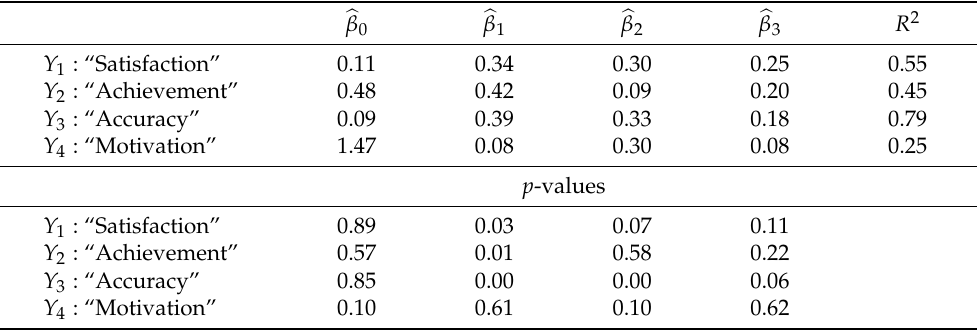
Figure 1. Regression analysis of performance measures ( Y 1 , . . . , Y 4 ) on selected key training method variables ( X 1 : “Skills/Knowledge”, X 2 : “Importance”, X 3 : “Improvement”) for employees in the banking sector. Non-parametric fit (red). Table 1. Estimated parameters with associated p -values and coefficient of determination R 2 in the regression of performance measures ( Y 1 , . . . , Y 4 ) on selected key training method variables ( X 1 , X 2 , X 3 ) for employees in the banking